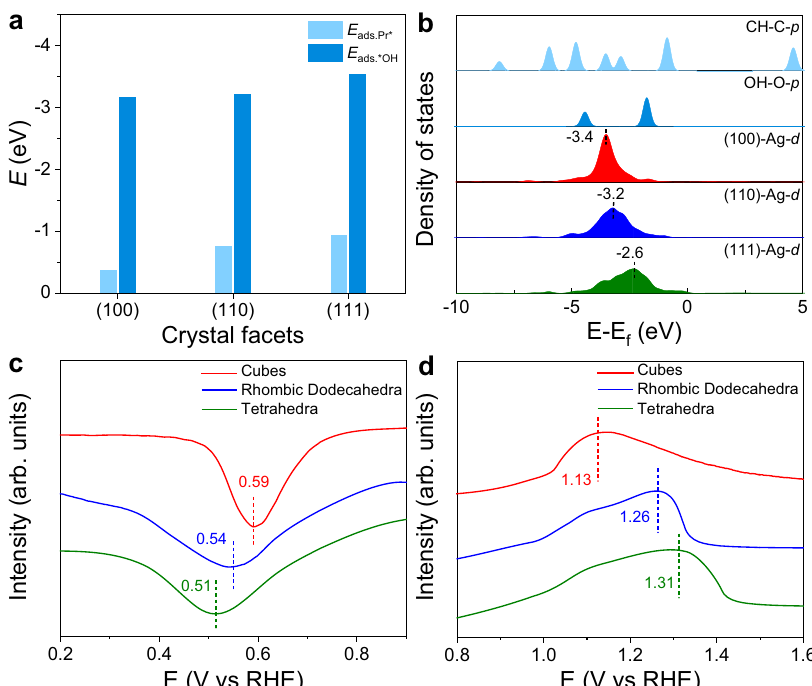
Fig. 4 Mechanisms of facet effect. a E ads.Pr* and E ads.*OH over the three types of Ag 3 PO 4 facets. b Projected DOS plots of d orbitals of Ag over the three types of Ag 3 PO 4 facets with p orbitals of C in Pr * and O in * OH. The d -band center was marked via short dash. c , d The single reduction of linear sweep voltammetric curves ( c ) and propylene stripping voltammograms ( d ) with the scan rate of 100 mV s − 1 over Ag 3 PO 4